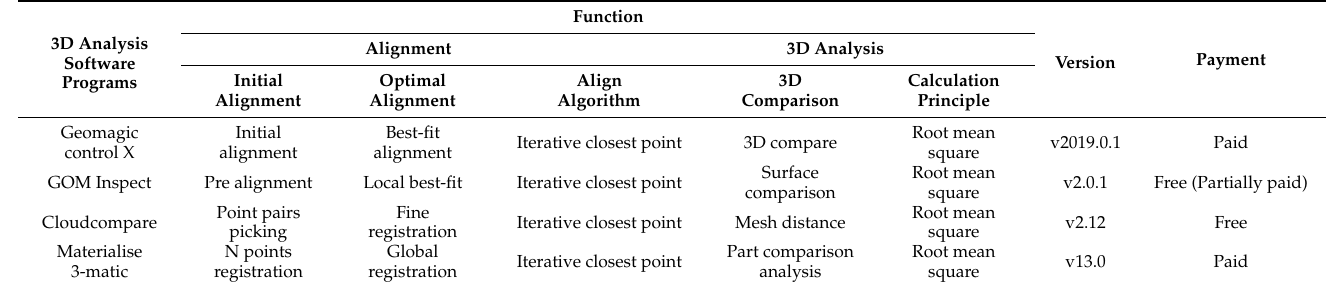
Table 1. Three-dimensional analysis software programs